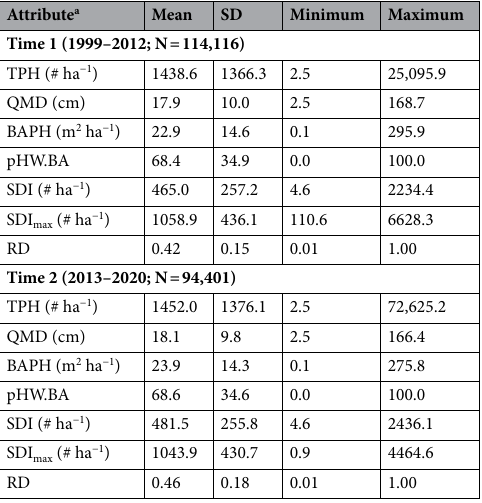
Table 1. Plot-level ( N = 208,517) summary of key structural and compositional attributes by Time 1 (1999– 2012) and Time 2 (2013–2020). a TPH is trees per ha (stem density), QMD is quadratic mean diameter, BAPH is total basal area per ha, pHW.BA is the percentage of basal area in hardwood species, SDI is additive stand density index, SDI max is the maximum stand density index, and RD is the relative density.